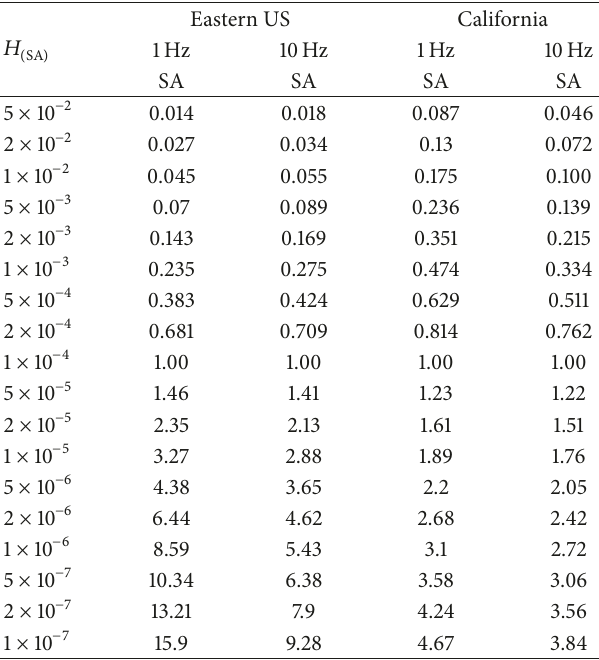
Table 3: Typical normalized spectral acceleration hazard curve values of ASCE/SEI 43-05 [3].